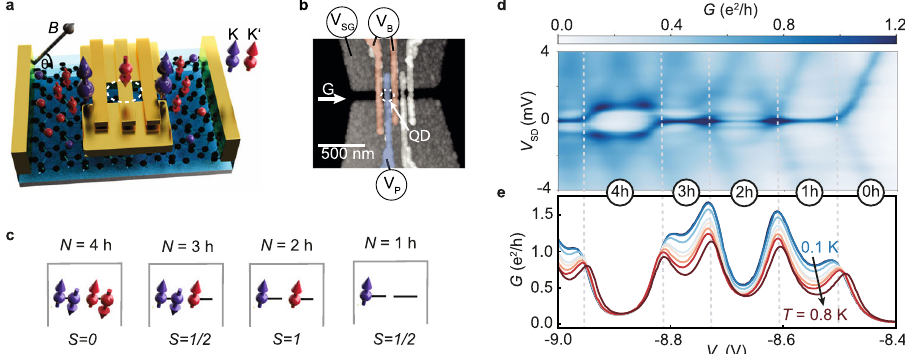
Fig. 1 Kondo effect in bilayer graphene quantum dot devices. a Schematic of the quantum dot device in bilayer graphene. A magnetic fi eld is applied at an angle Θ relative to the graphene fl ake. b Atomic force micrograph of the gate structure on top of the bilayer graphene stack. Three fi nger gates are used to form the quantum dot (dashed white circle), with two tunable barriers (red) and a plunger gate (blue). c Level- fi lling scheme of the QD with the number of charge carriers N . d Finite-bias measurement of a quantum dot that is strongly coupled to the leads. The grey dashed lines indicate plunger-gate voltages where additional holes enter the dot. A fi nite conductance is observed in the Coulomb blockaded regions (between dashed lines) at V SD = 0 mV, when the dot is charged with N = 0 to N = 4 holes. e Typical temperature dependence of Kondo resonances at a low bias voltage ( V SD = 2 μ